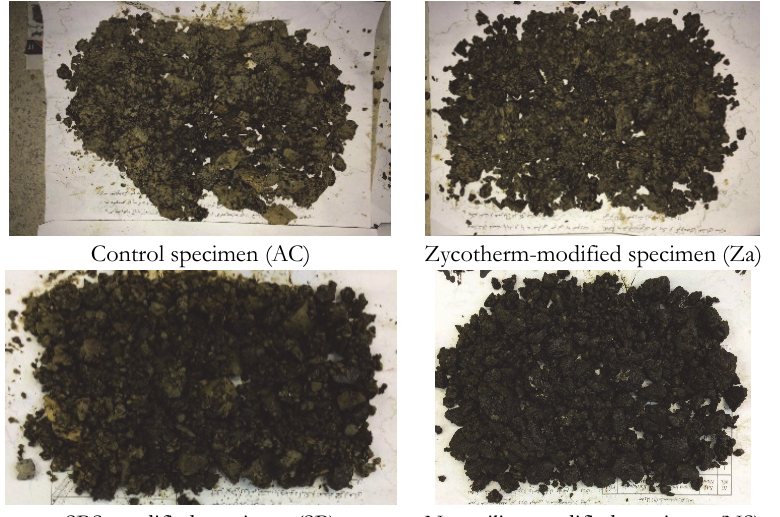
Figure 6: Results of boiling water for modified and non-modified